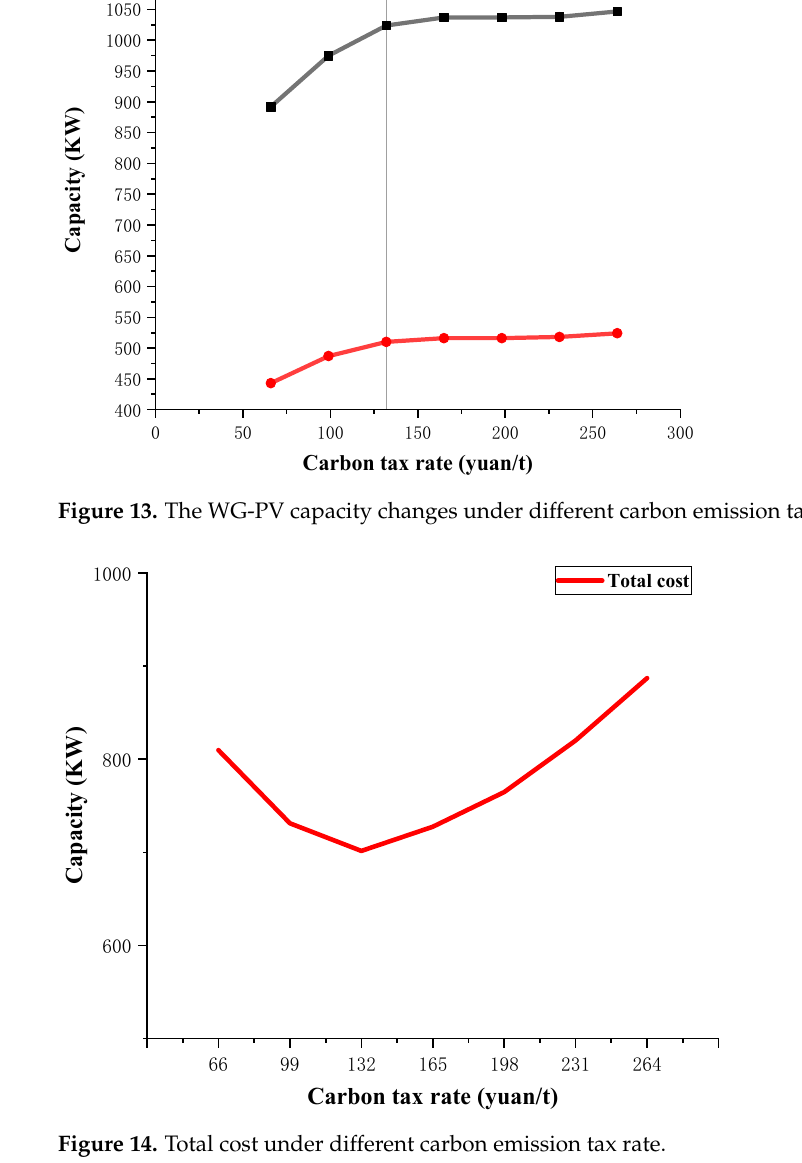
Figure 14. Total cost under different carbon emission tax rate.